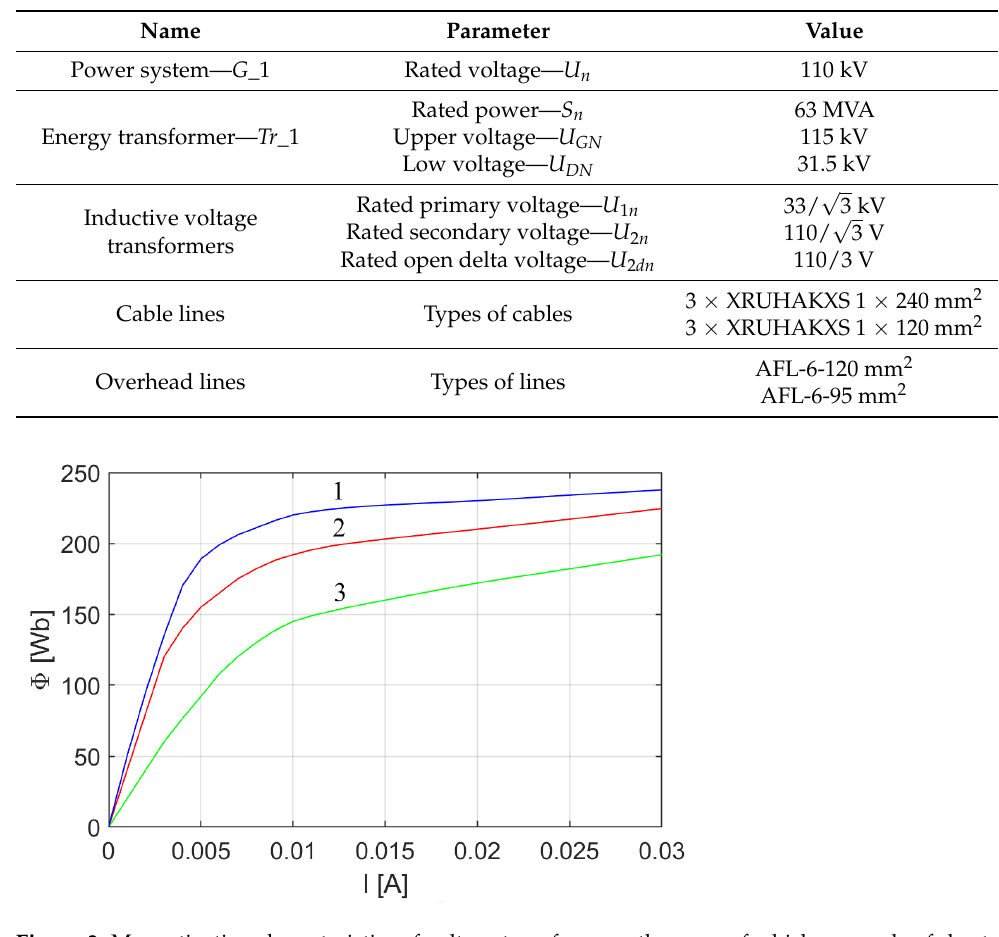
7 of 19 Figure 2. Model of single-phase voltage transformer for phase L 1 made in EMTP/ATP software. For the purposes of conducting the analysis in the form of computer simulations, it was necessary to implement individual elements of the system, the parameters of which